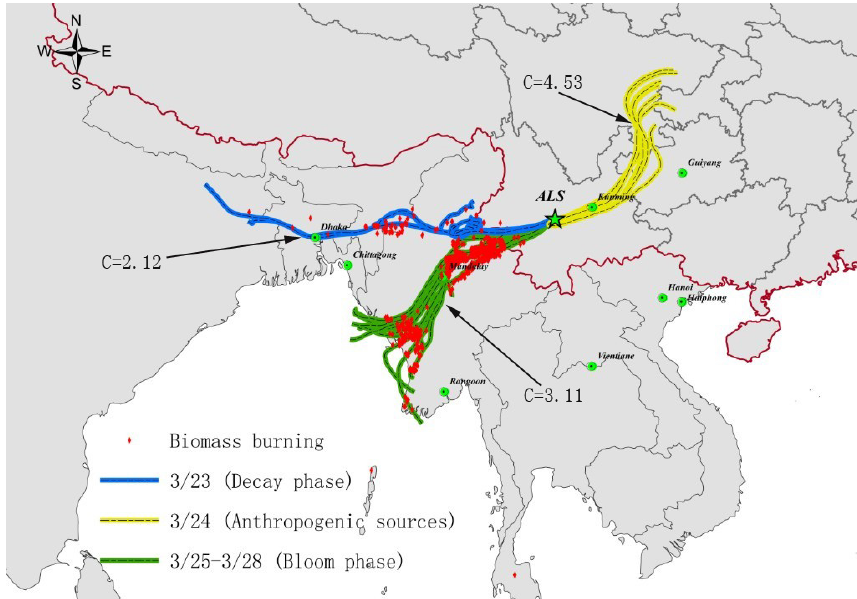
Figure 13. Backward trajectories of air masses and the sites of fire events in 23–29 March 2012 during the non-ISM period (October–April). The TGM level (C) was 4.53ngm − 3 with the air masses from inland China. The TGM level was 3.11ngm − 3 with the air masses from Myanmar and high-frequency fire